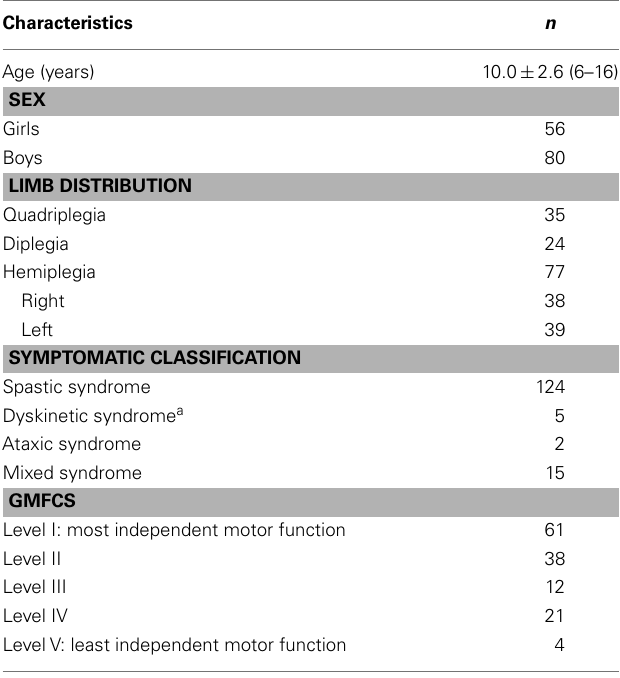
Table 1 | Participants’ characteristics ( n = 136)